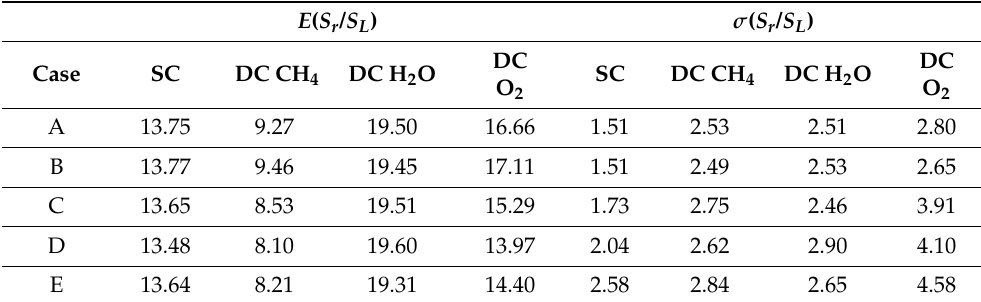
Table 8. Mean value E and standard deviation σ of normalised displacement speed S r / S L for the c = 0.8 isosurface value for all